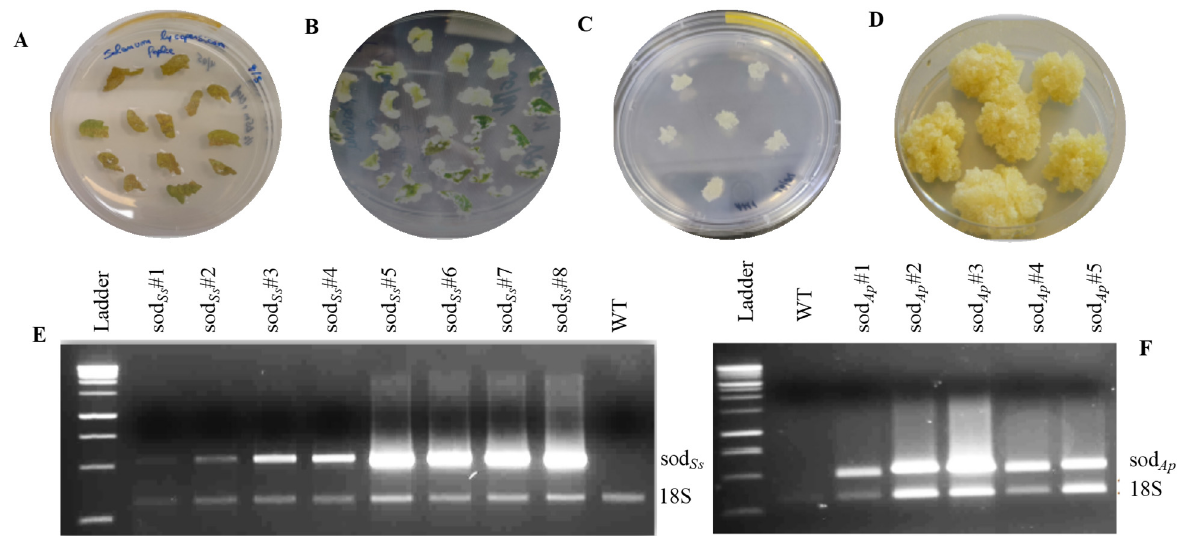
Figure 1. Transgenic calli production from tomato cotyledons (cv MicroTom) and RT-PCR analysis of recombinant SODs. ( A ) Callus induction in cotyledon pieces; ( B ) callus formation on MS medium containing NAA and kinetin; ( C ) callus lines regenerated; ( D) transgenic clones; RT-PCR analysis of